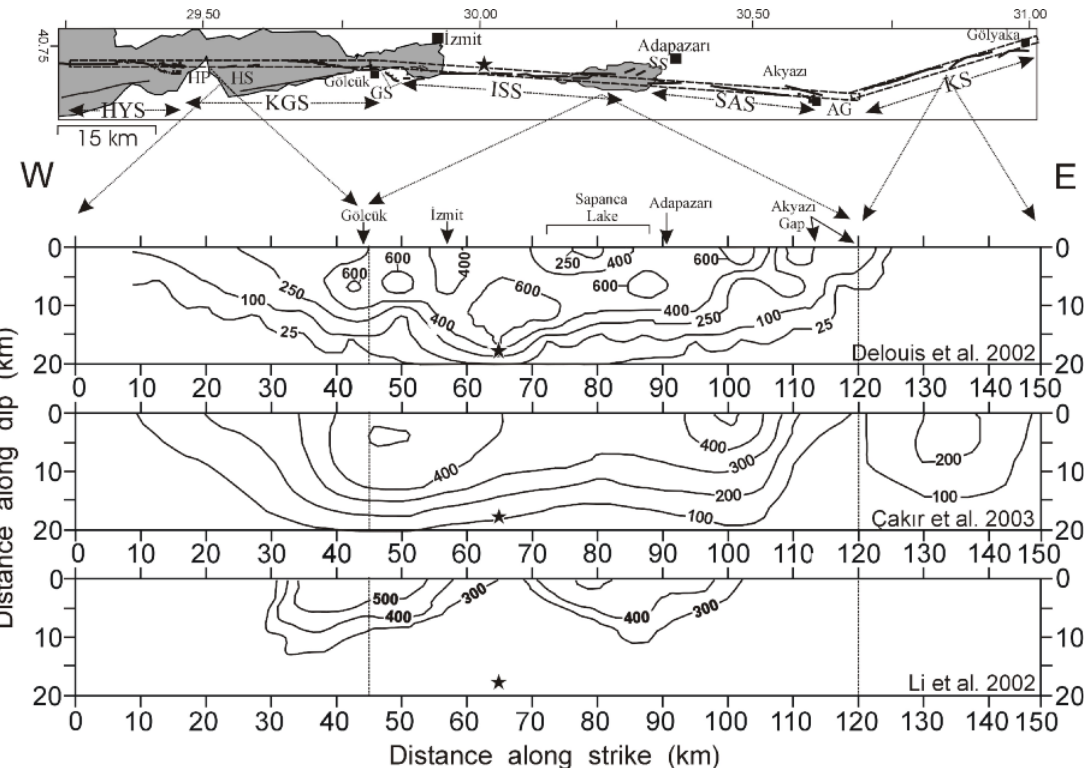
! Figure 4. Slip models of the 1999 İ zmit earthquake arising from earlier studies. The slip model of Deluois at al. [2002] was recovered from joint inversion of the seismic waveforms (near-field + teleseismic) and geodetic data (GPS + InSAR). Çakır et al. [2003] inverted the geodetic data (GPS + InSAR), while Li et al. [2002] modeled teleseismic displacement waveforms. The map of the surface rupture extent for correlating the slip distribution in the depth with the surface rupture trace is also shown. See caption of Figure 3 for abbreviations. Solid star, hypocenter used in the present